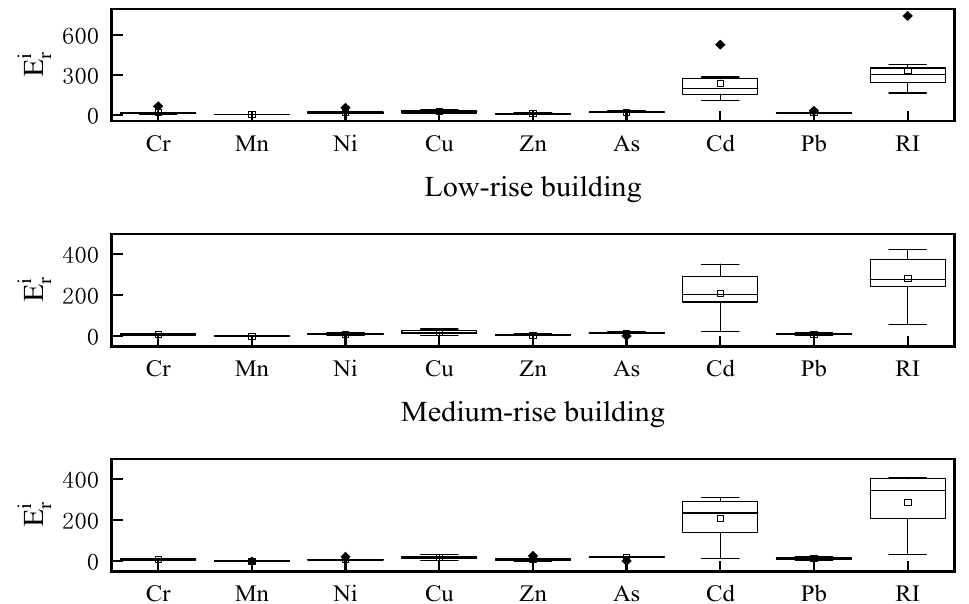
Figure 4. Potential ecological risk indices of atmospheric dust fall on buildings differing in height. RI: The total potential ecological risk hazard indices.